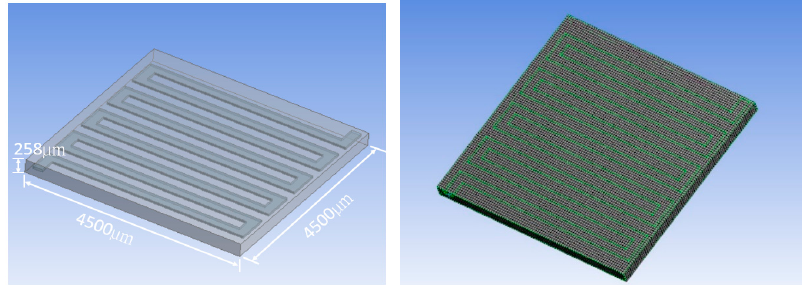
Figure 1. Features of the thermostat and meshed model.